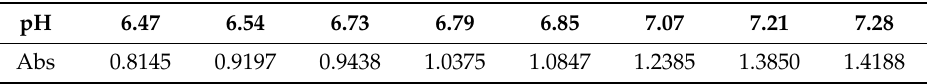
Table 5. Correspondence between pH and the absorbance of bromothymol blue at 614